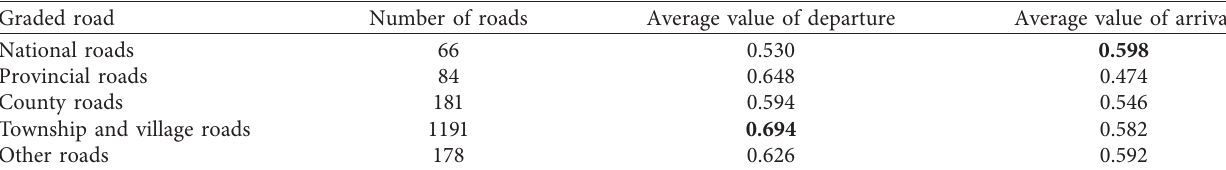
Table 1: Average activity of graded